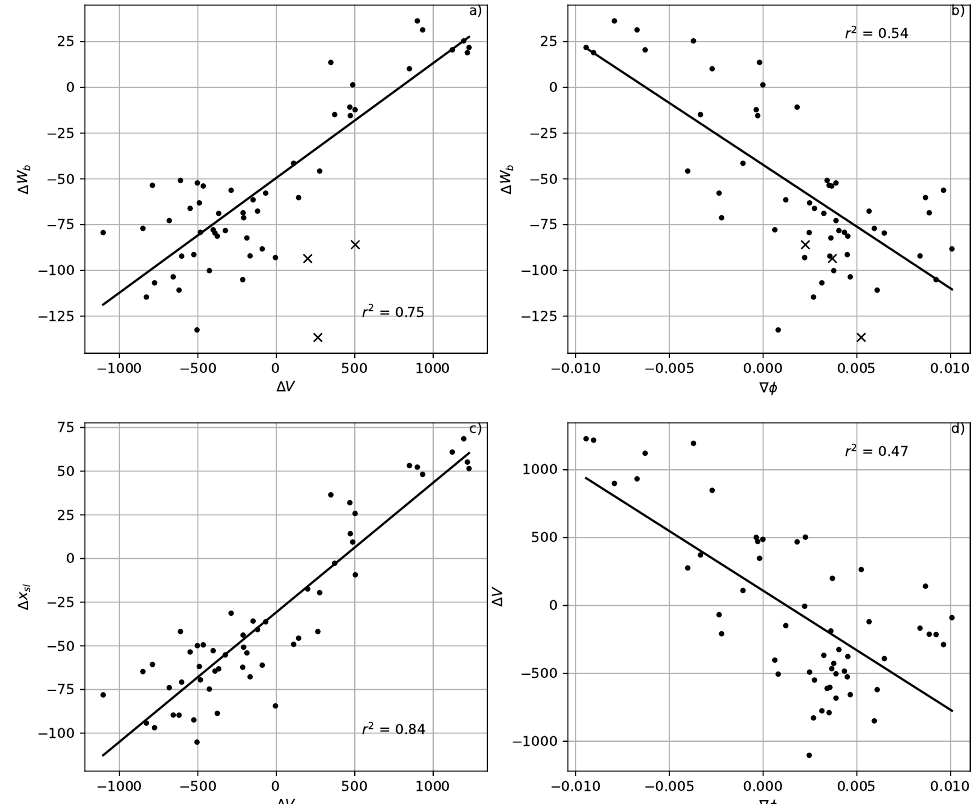
Figure 13. Correlations of profile volume change, beach width, coastline position, and coastline gradient. ( a ) Correlation of profile volume change and beach width change, ( b ) coastline gradient and beach width change, ( c ) coastline position change and volume change, and ( d ) coastline gradient and volume change. Data points are for the project area only and based on JARKUS dataset, for the period between April 2015 and 2020. Observations marked with a cross are treated as outliers in the determination of the correlation coefficients. Beach width changes at these locations are dominated by alongshore infilling of a local stepback in the dunefront at the edge of the original sea dike (see Figure 11a,d km